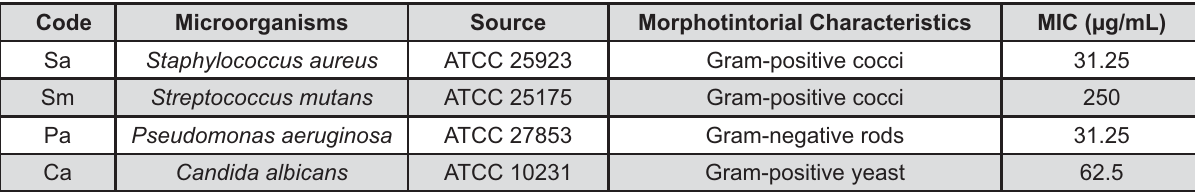
Figure 1- Standard microorganisms used in the microbiological experiments and minimum inhibitory concentration (MIC) values for